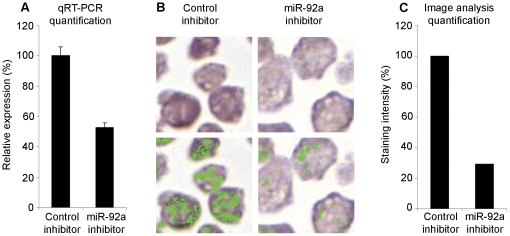
Validation of miR-92a in situ hybridization probe.
A) Downregulated of miR-92a in MDA-231 cells was validated and confirmed by qRT-PCR. B) Detection of miR-92a using in situ hybridization in MDA-231 cells after downregulation of miR-92a. Lower panel shows the definition of positive pixels identified by the digital image analysis program. C) Quantification of positive pixels by the image analysis program.